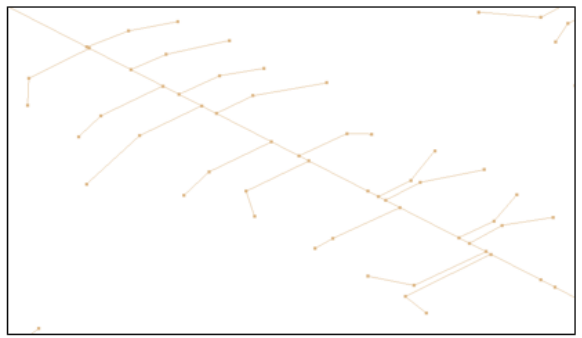
Figure 4. Representation of topology in the Nanaimo water network modelled according to the Utility Network ADE. Figure from “FZK Viewer” software